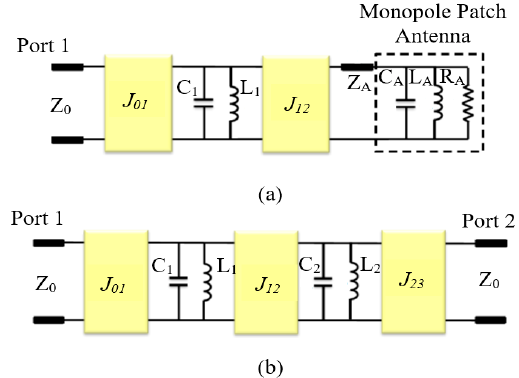
Figure 3. Microwave equivalent circuit: ( a ). The proposed filtering antenna ( b ). The second ‐ order bandpass filter.